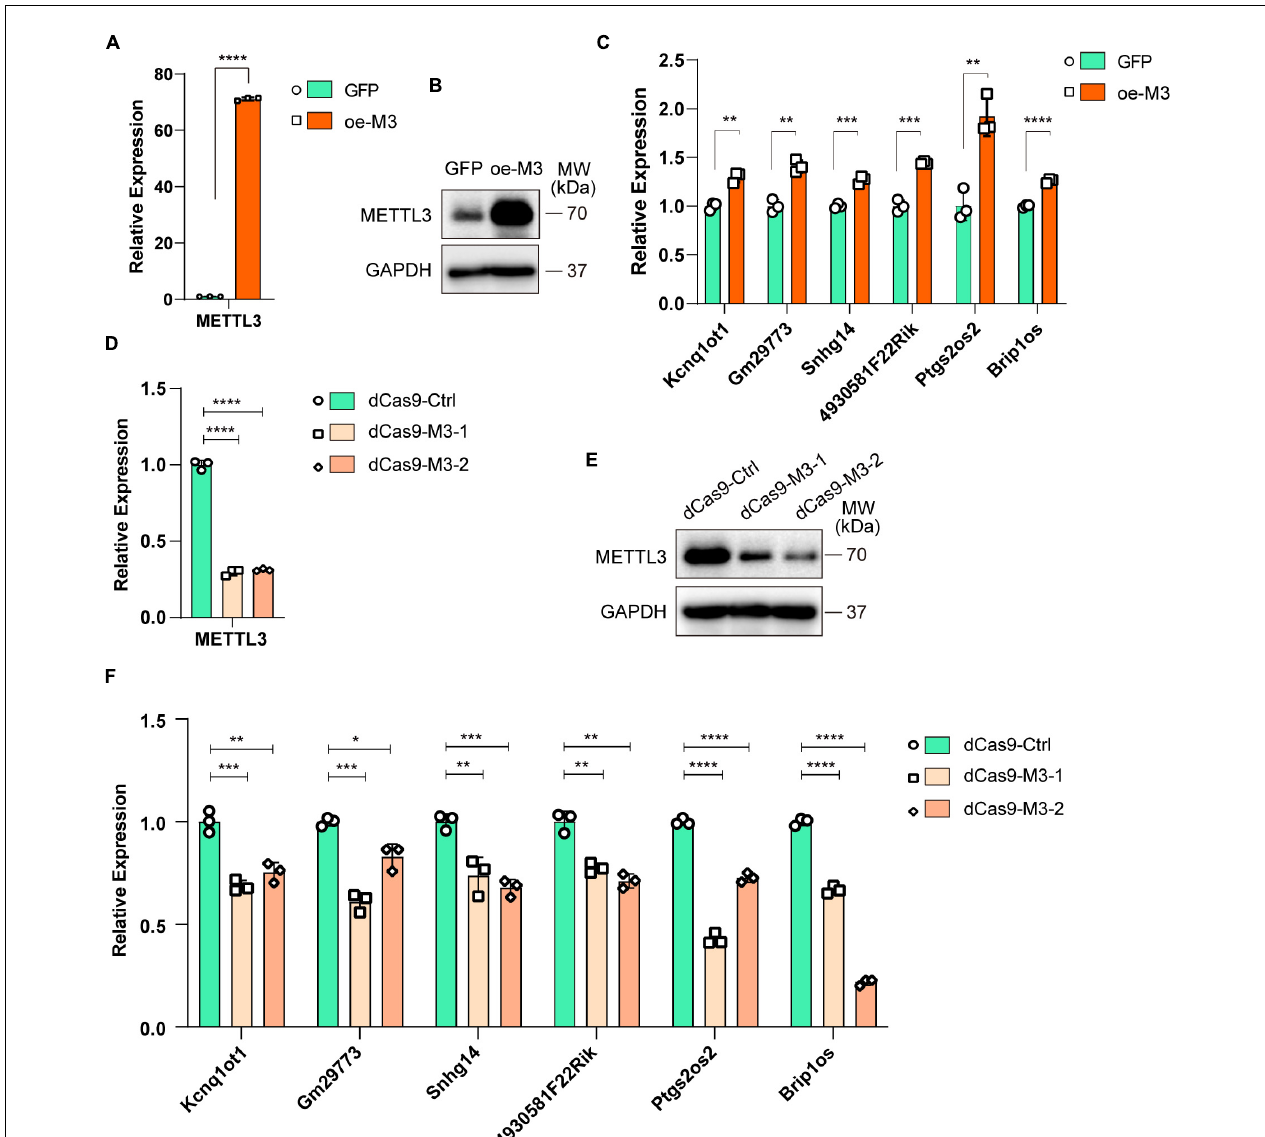
FIGURE 5 | Myogenesis associated lncRNAs are regulated by m 6 A methyltransferase METTL3. (A) qRT-PCR shows the RNA expression level of METTL3 in METTL3-overexpressing C2C12 cells. GFP-overexpressing C2C12 cells as negative control. (B) Western blot detected the protein expression levels of METTL3 in METTL3-overexpressing C2C12 cells. (C) qRT-PCR shows the expression of myogenesis associated lncRNAs in METTL3-overexpressing C2C12 cells. (D) qRT-PCR shows the RNA expression level of METTL3 in METTL3 knockdown C2C12 stable cell lines. A nonsense sequence constructed to dCas9 repressor as negative control. (E) Western blot detected the protein expression levels of METTL3 in METTL3 knockdown C2C12 stable cell lines. (F) qRT-PCR shows the expression of myogenesis associated lncRNAs when METTL3 was knockdown. Data are presented as Mean ± SD; p value: * p < 0.05, ** p < 0.01, *** p < 0.001, **** p <